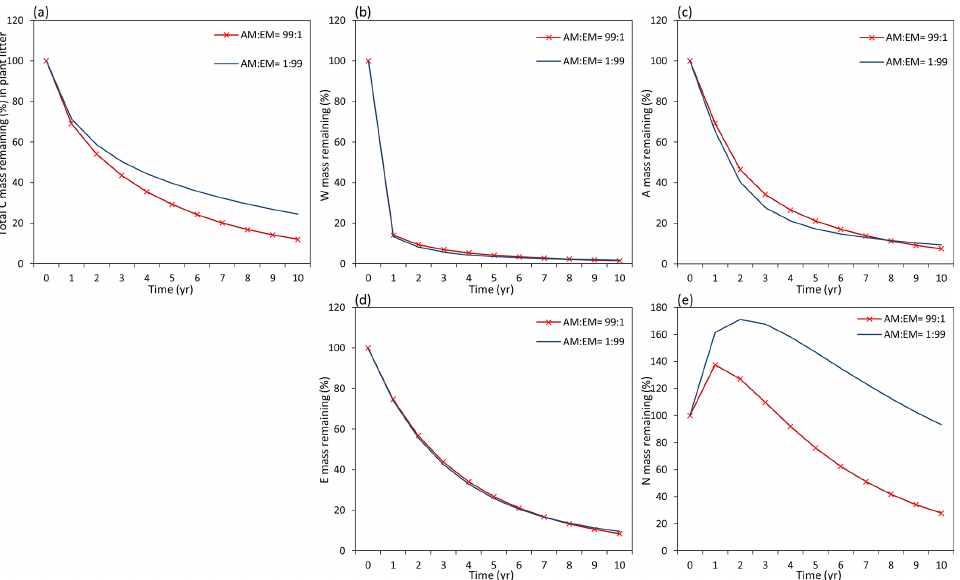
Figure D2. Dynamics of plant foliage (leaf) litter decomposition in AM-dominated vs. EM-dominated environments. (a) Loss of total carbon mass from foliage litter. (b, c, d) Dynamics of loss of labile carbon components (W – water-soluble C pool, A – acid-hydrolysable C pool, E – ethanol-soluble C pool). (e) Dynamics of loss of recalcitrant (non-hydrolysable) carbon ( N pool). The initial W , A , E , and N composition of leaf material is 25%– W , 45%– A , 12%– E , and 18%– N (typical for plant foliage).